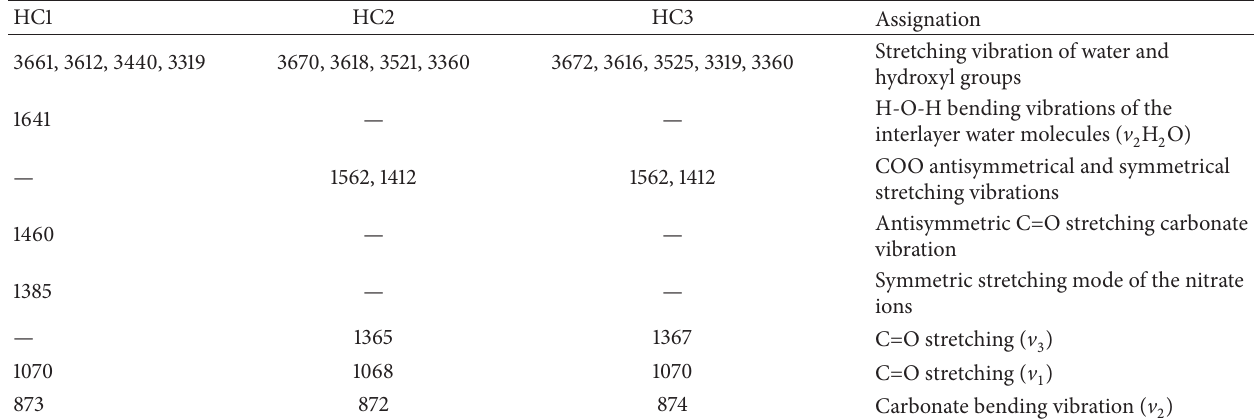
Table 3: Wavenumbers and assignations of the bands of the samples.